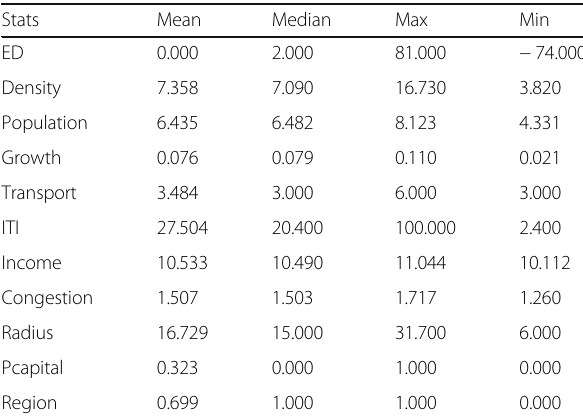
Table 2 Descriptive statistics of variables